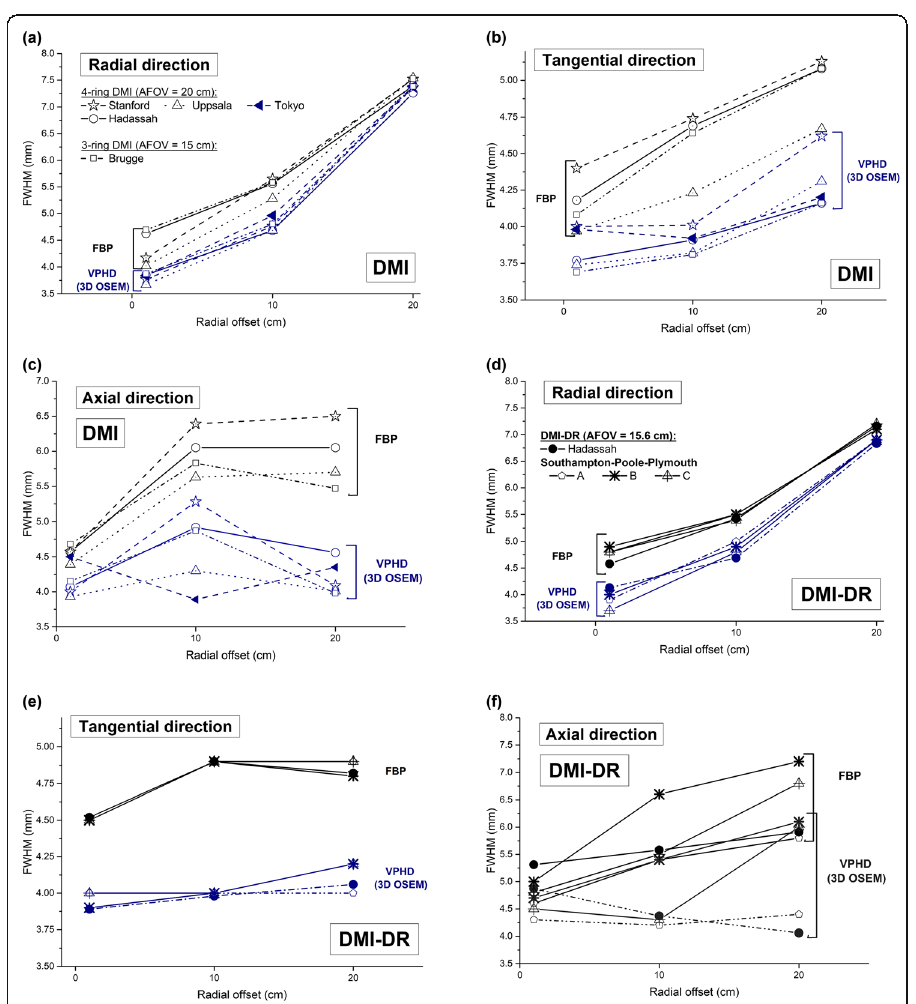
Fig. 1 Radial, tangential, and axial spatial resolutions in mm (FWHM) at 1, 10, and 20 cm radial offset obtained a Hadassah for the a - c DMI and d - f DMI-DR systems using FBP and VPHD (3D